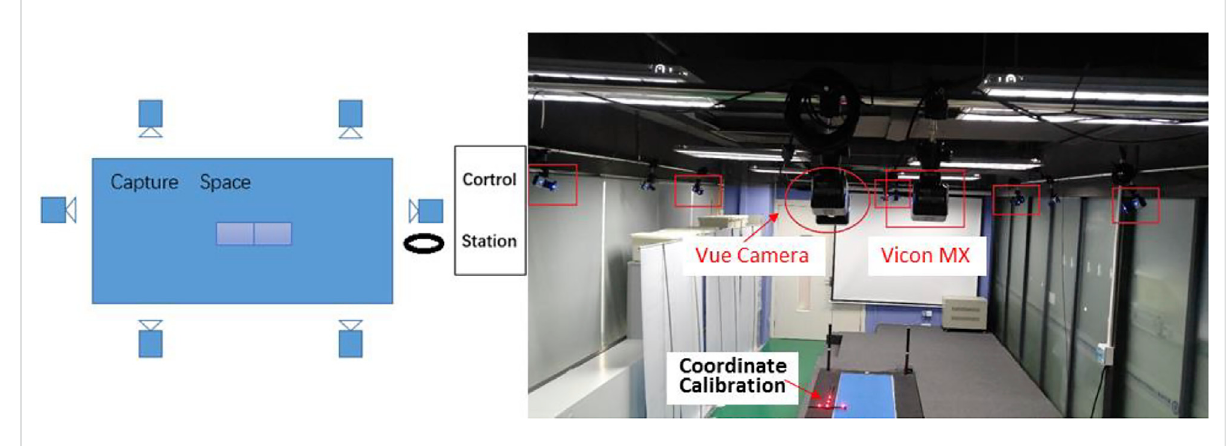
FIGURE 1 Overview of the experimental environment and